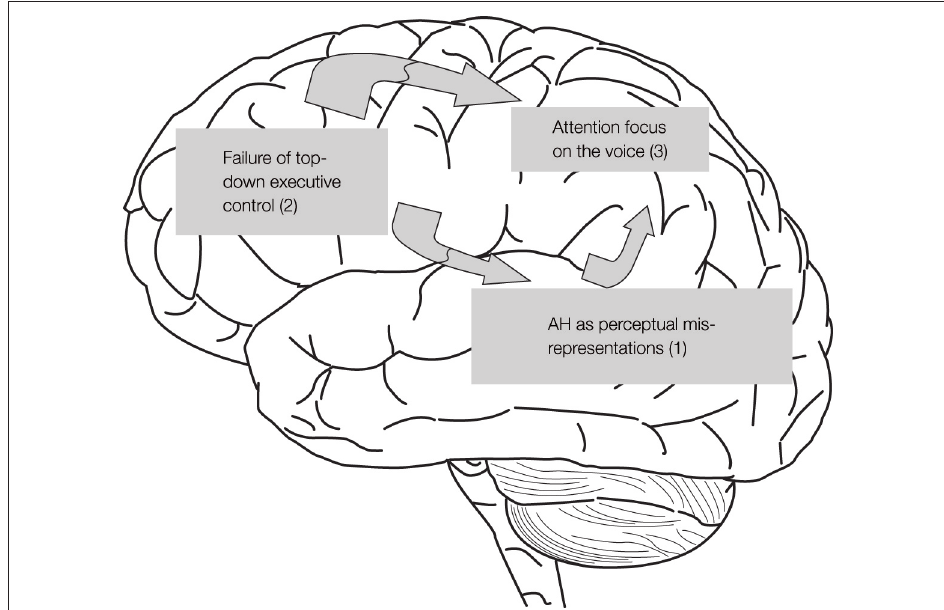
Figure 1 | Outline of a model for auditory hallucinations (AH) as perceptual mis-representations, parietal lobe attention enhancement and failure of prefrontal executive suppression control. The model emphasizes the involvement of the middle and superior temporal gyri (1) for the generation of AH, prefrontal cortex (2) for top–down executive control, and parietal cortex (3) for attention